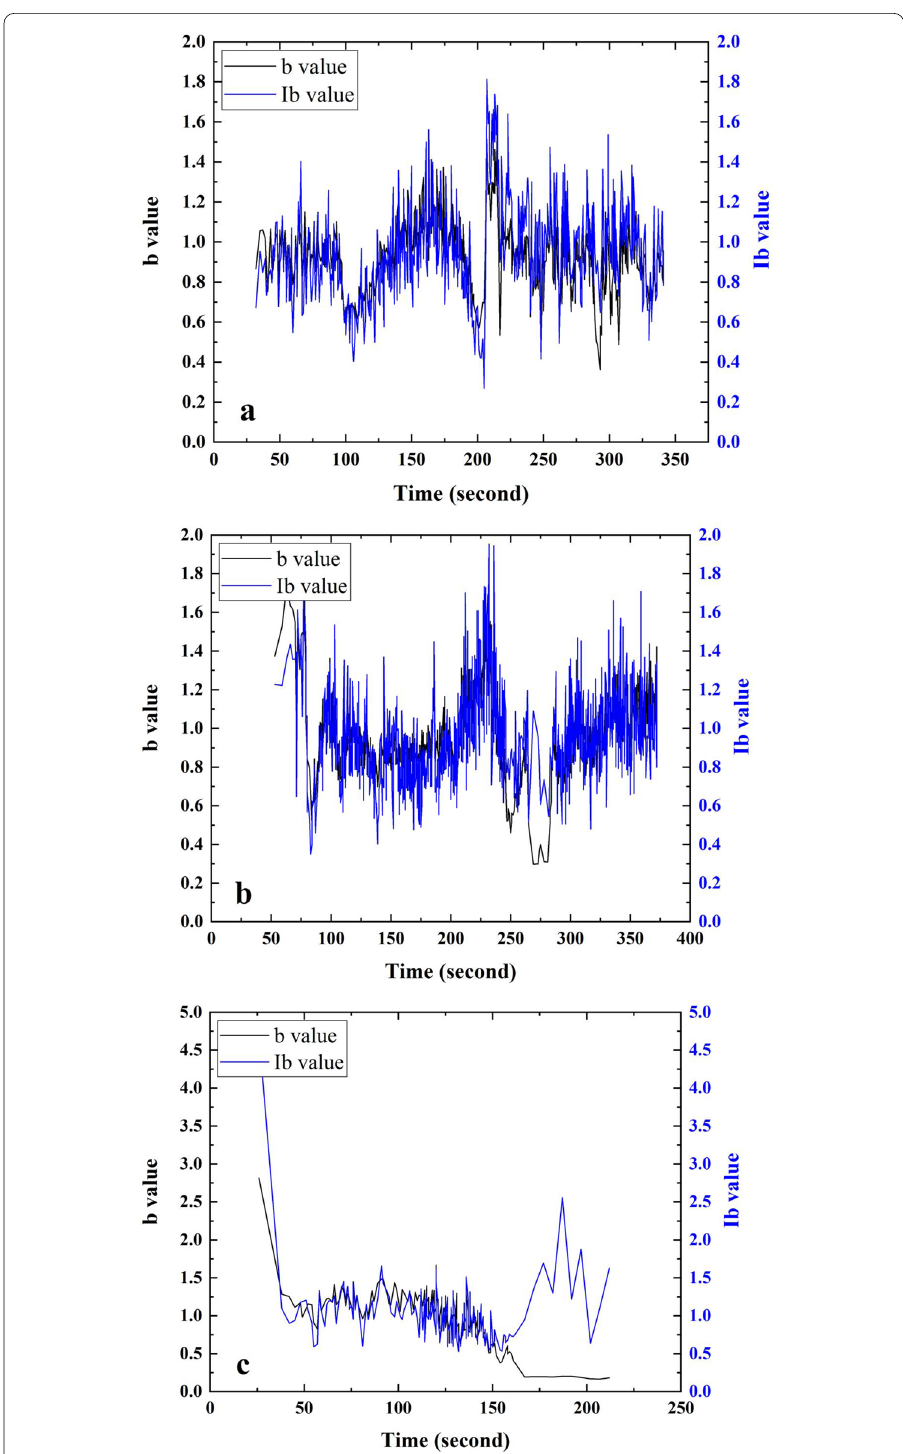
Fig. 11 The b-value (GBR) and Improved b-value (Ib) (PAC) were compared and plotted against experiment duration in all three cases i.e. ( a ) intact rock block ( b ) block with horizontal joint set and ( c ) block with vertical joint